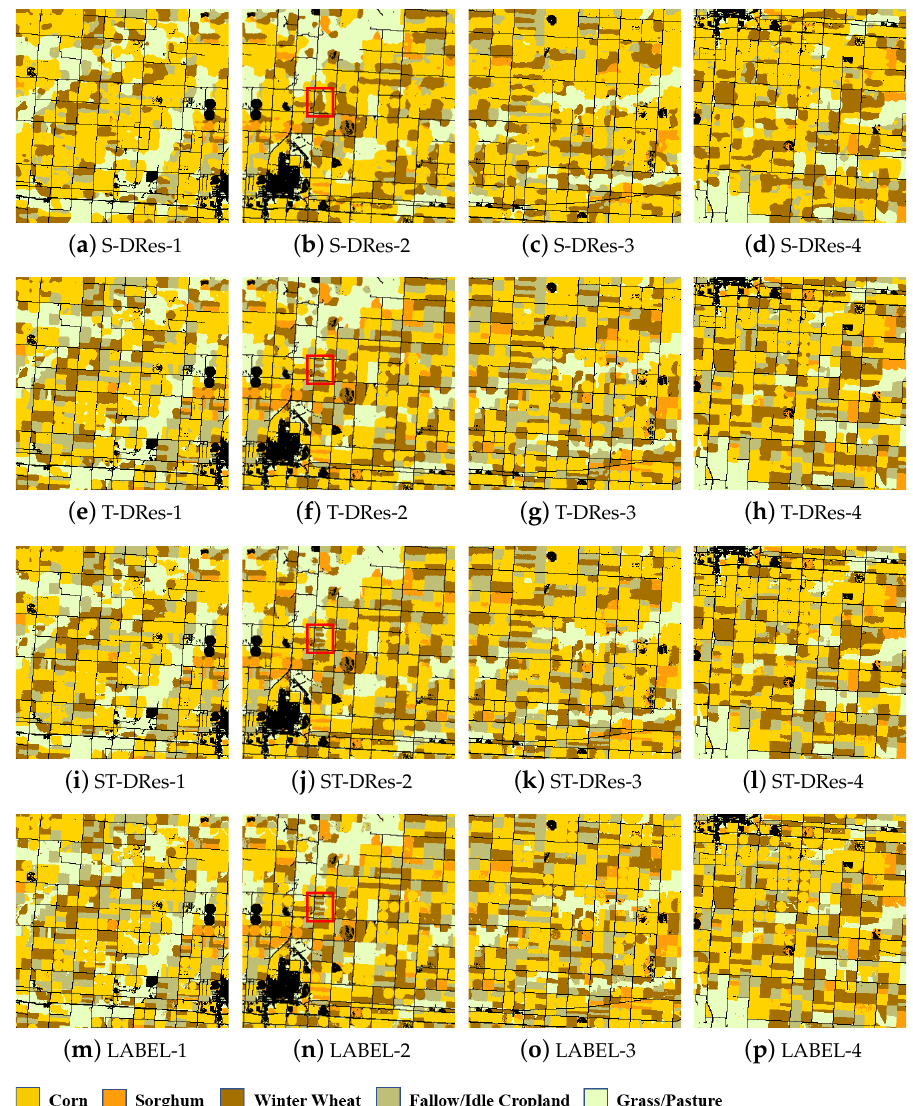
Figure 7. Four small sub-pixel example maps (64 × 64) in the Sherman dataset are displayed by using different temporal and spatial information. ( a , e , i ) represent the results generated by the three methods (S-DRes,T-DRes, ST-DRes) on example map-1, while ( m ) is the corresponding label. Similarly, ( b , f , j ) represent the results generated by the three methods on example map-2, while ( n ) is the corresponding label; ( c , g , k ) represent the results generated by the three methods on example map- 3, while ( o ) is the corresponding label; ( d , h , l ) represent the results generated by the three methods on example map-4, while ( p ) is the corresponding label. It shows that T-DRes is more capable of generating sub-pixel maps that are closest to the ground truth than S-DRes architecture. ST-DRes outperformed the other two models, which is especially noticeable in the highlighted red box